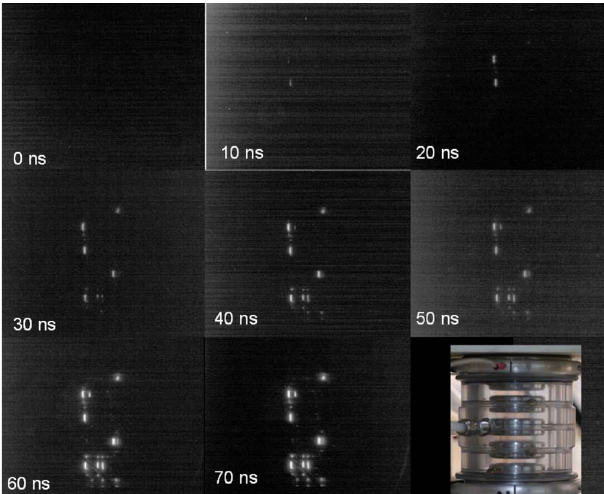
FIG. 23. (Color) Framing camera images of light emitted by the HCEI switch during the breakdown process. The frames were 5- ns wide and started at 10-ns intervals. Note that the light starts in the triggered gap, migrates to the top of the switch, and then to the bottom of the switch. Also note that three of the gaps only have one breakdown